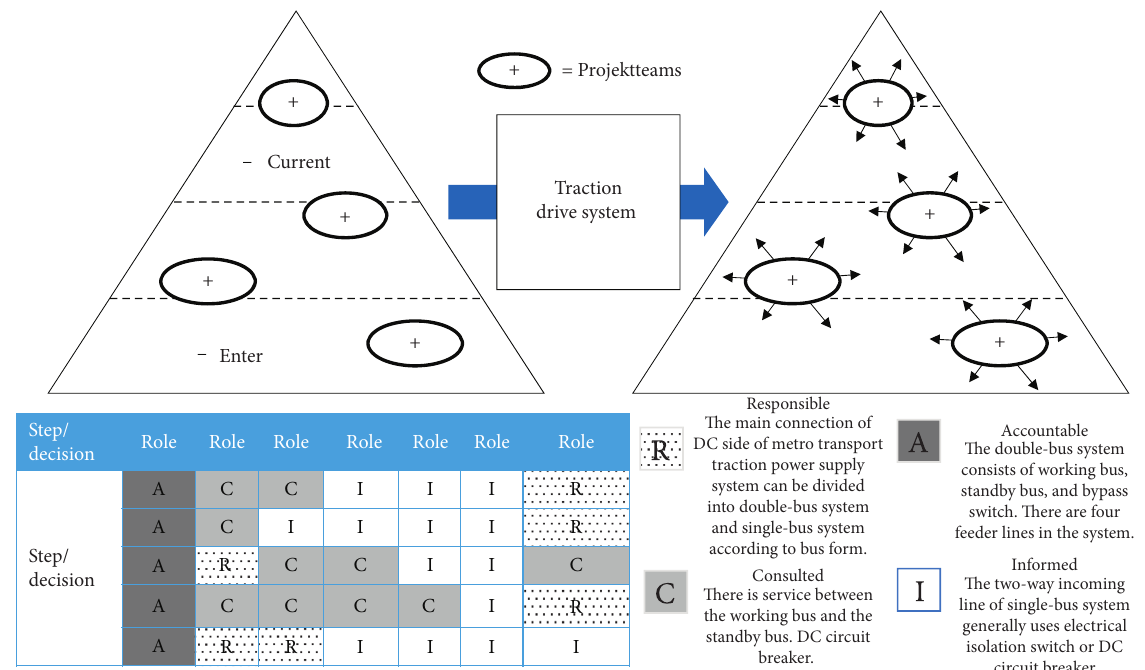
Figure 5: Subway transportation traction power supply system. The handle process is on the top, and the specific role for decision-making is shown at the bottom.